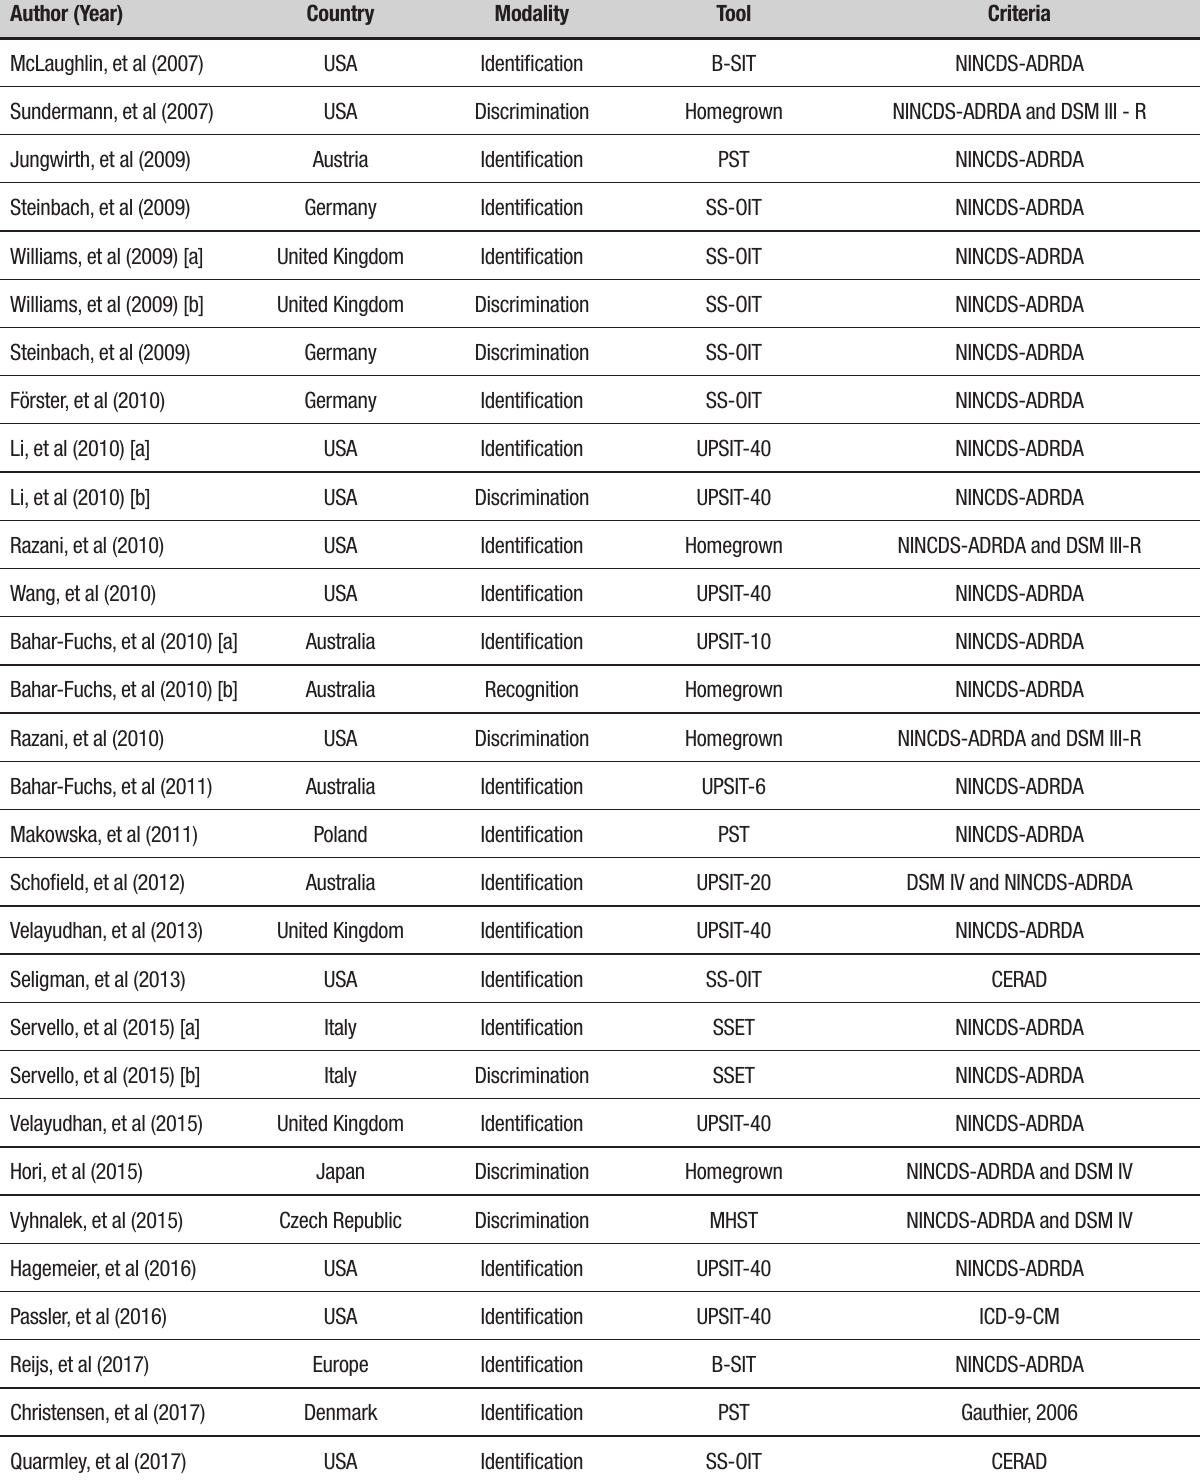
Table 1. Study characteristics